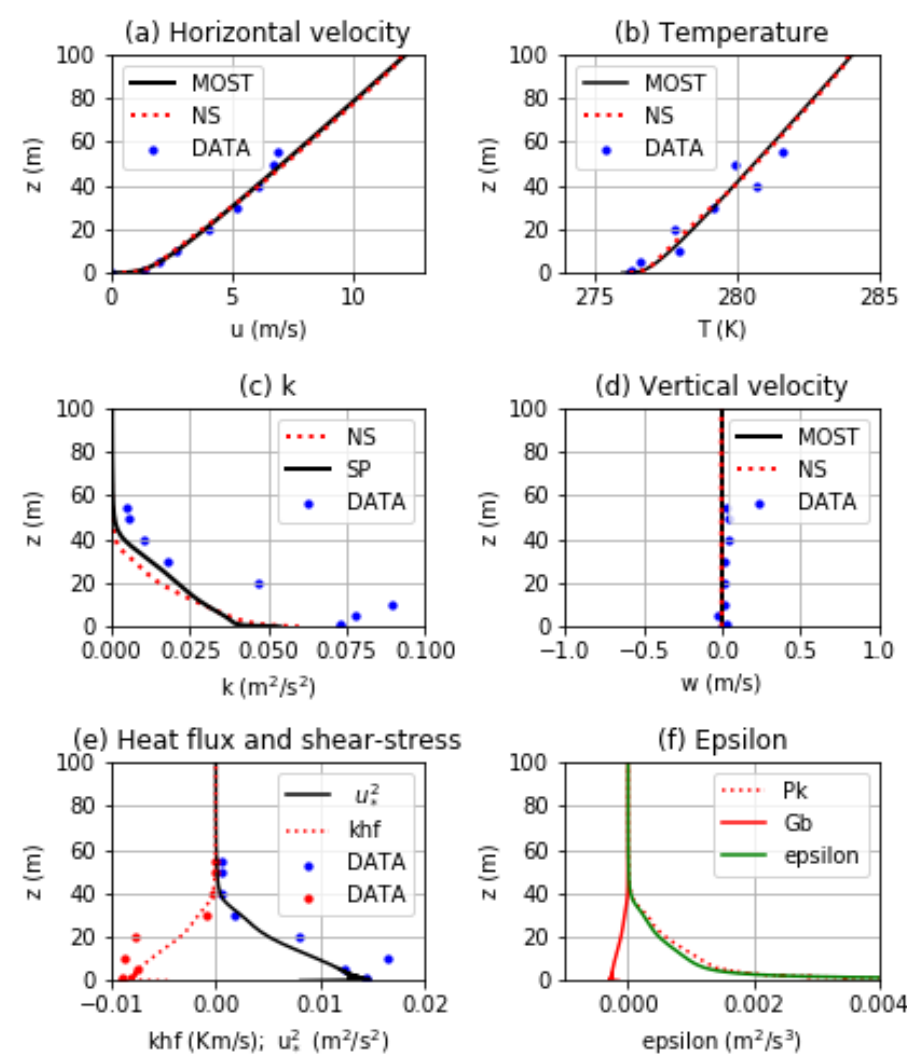
Figure 3. Comparison of the numerical solution (NS) with the reference profiles (obtained from MOST) and the CASES-99 data, where applicable for the SBL: ( a ) horizontal velocity; ( b ) potential temperature; ( c ) turbulent kinetic energy–SP refers to the simulated reference profile; ( d ) vertical velocity; ( e ) kinematic heat flux (khf = – u * θ * ) and shear-stress ( u * 2 ); and ( f ) numerical production and dissipation of k. The numerical results are shown for a position 2000 m from the upwind boundary of the domain.